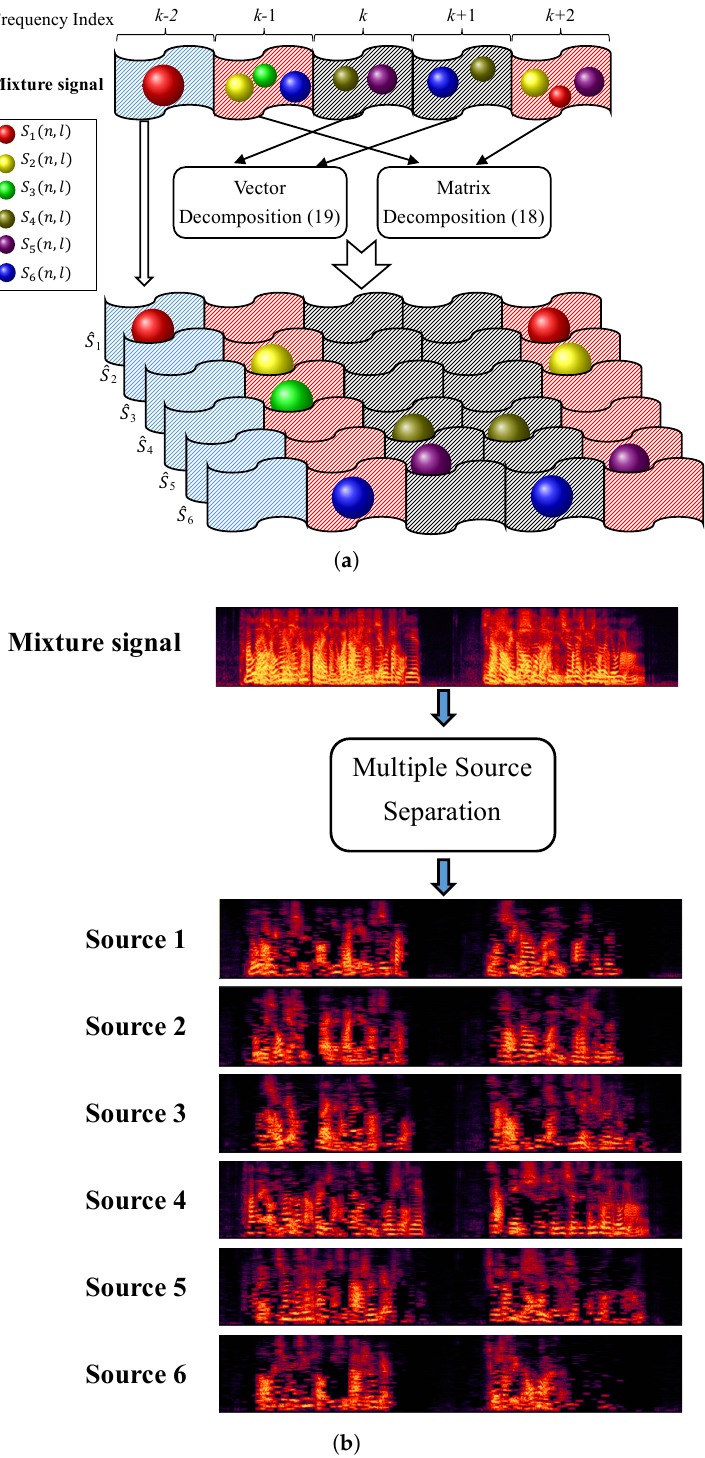
Figure 5. ( a ) Example of a TF component extraction of the proposed framework. Both the frame length and number of STFT points are 2048. Each square represents a TF instant. Blue-shadowed squares denote the sparse component, while the squares in other colors denote the non-sparse component. The respective TF instants for each source (six sources for example) are indicated by a ball; ( b ) Example of six recovered signals from the mixture signal in the frequency